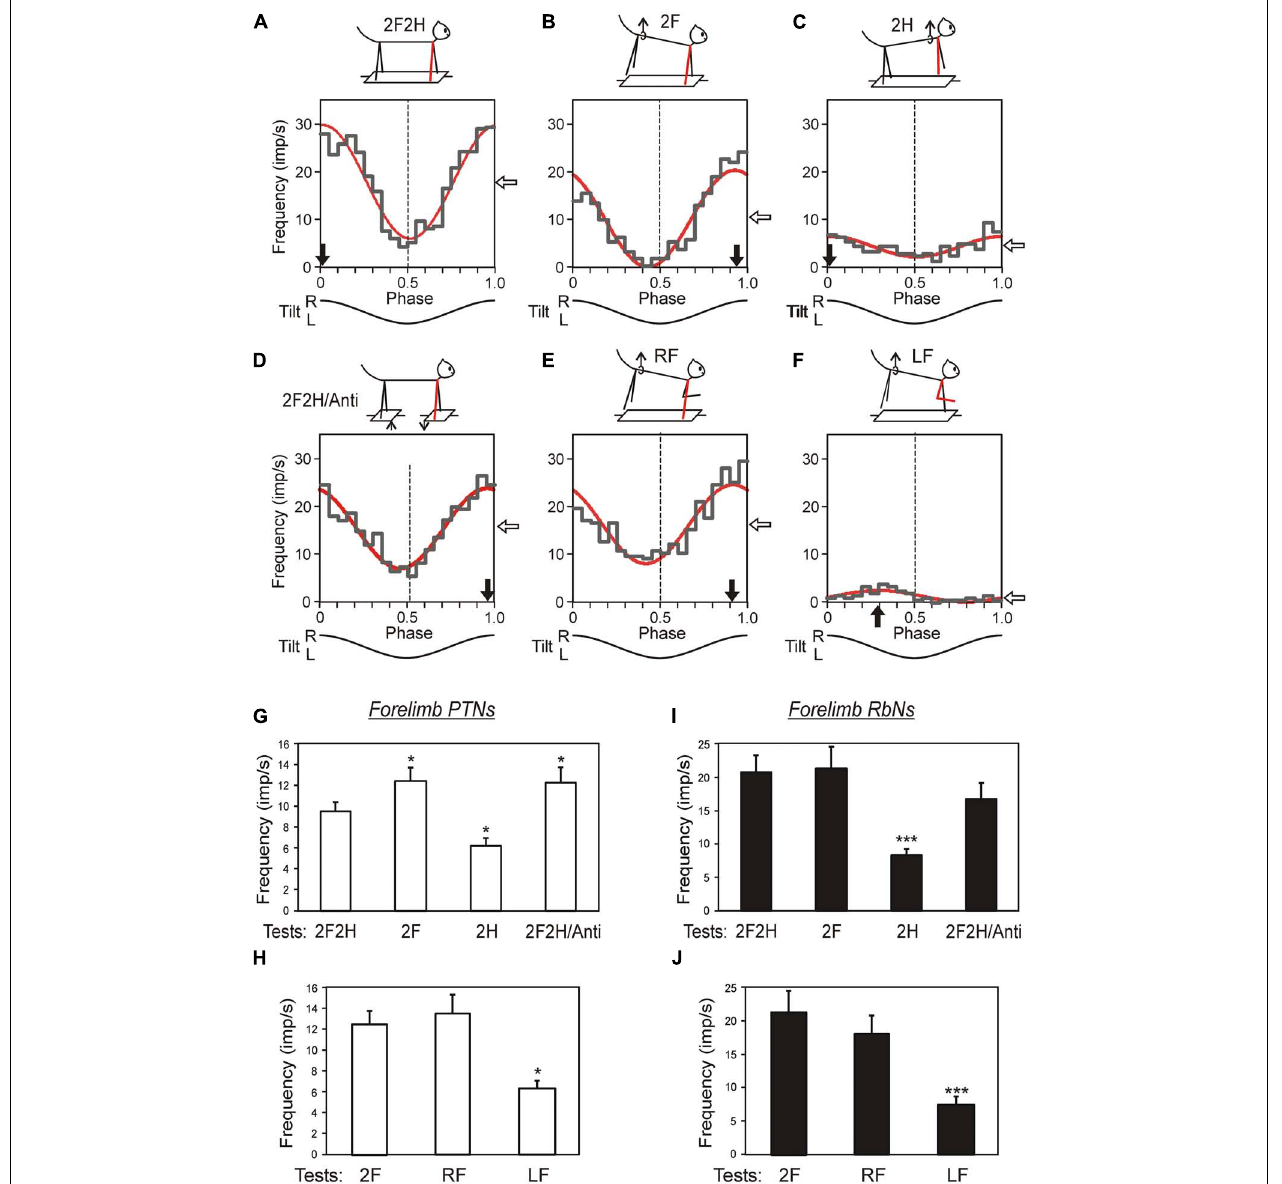
FIGURE 11 |Activity of corticospinal and rubrospinal neurons in the cat during postural corrections. (A–F) Activity of forelimb-related RbS neuron from left red nucleus during different postural tests.The neuron was related to the right forelimb (indicated by blue). (A) Control, standing on all four limbs (test 2F2H). (B) Standing on two forelimbs (test 2F). (C) Standing on two hindlimbs (test 2H). (D) Antiphase tilts of the platforms under the forelimbs and hindlimbs (test 2F2H/Anti). (E) Standing on the right forelimb (test RF). (F) Standing on the left forelimb (test LF). For each test the following are